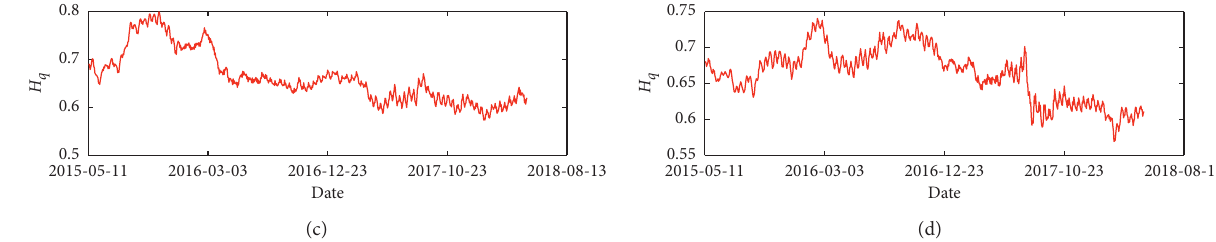
Figure 15: The time-varying scaling exponents for Chinese stock market volume and market participation willingness when window size is 250 days. (a) SME-YSI. (b) SSE50-YSI. (c) CSI300-YSI. (d)